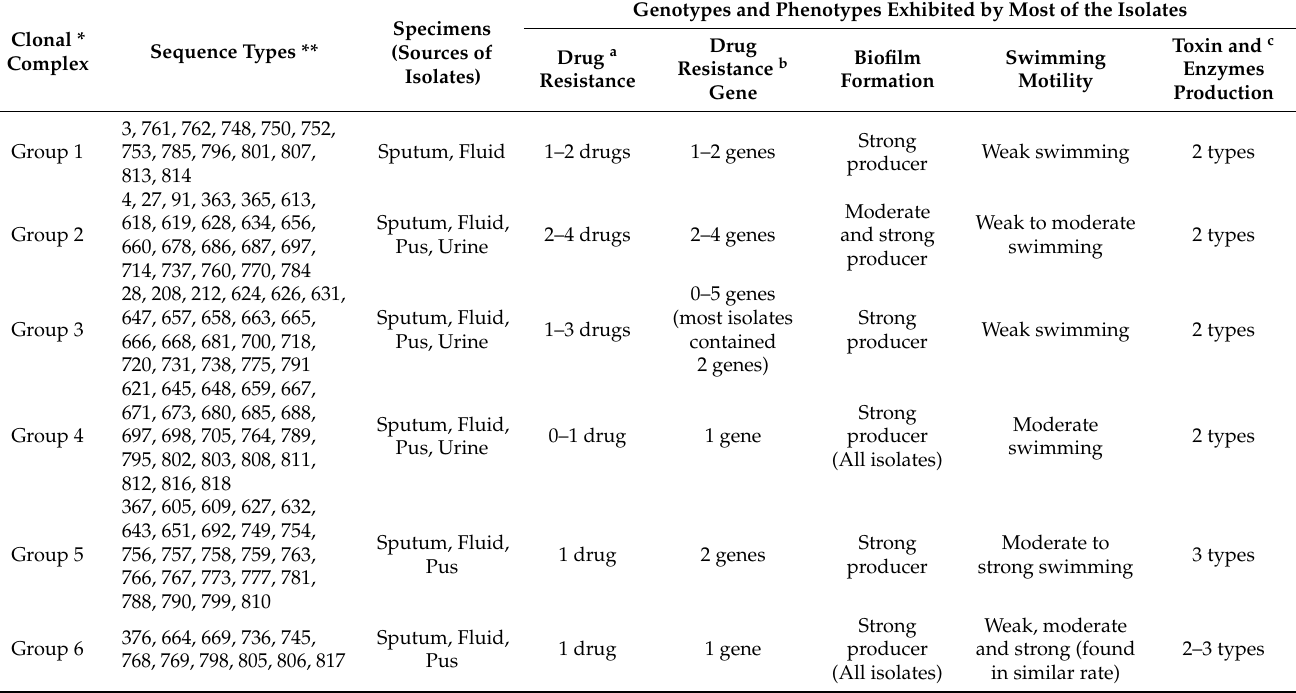
Table 5. Genotypic and phenotypic characteristics of S. maltophilia isolates in each clonal complex.